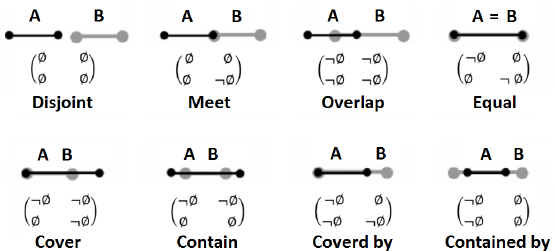
Figure 6. Eight kinds of topological relations for lines in a two-dimensional space [46].